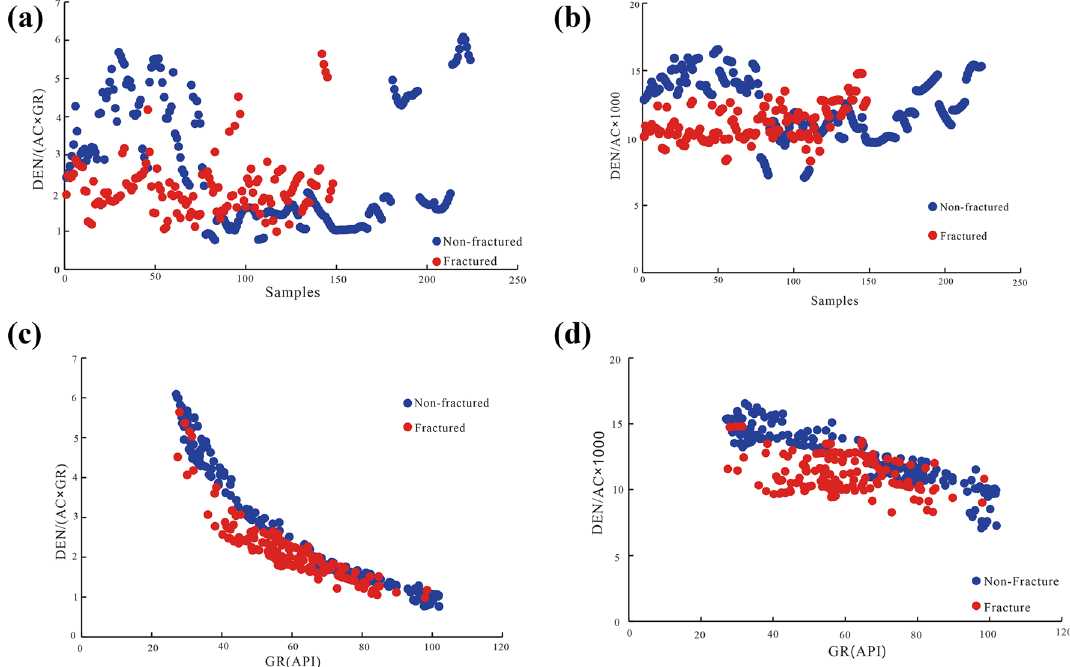
Figure 8. Logging sensitivity responses characteristics of fractured and intact rock after processing well-logging data.